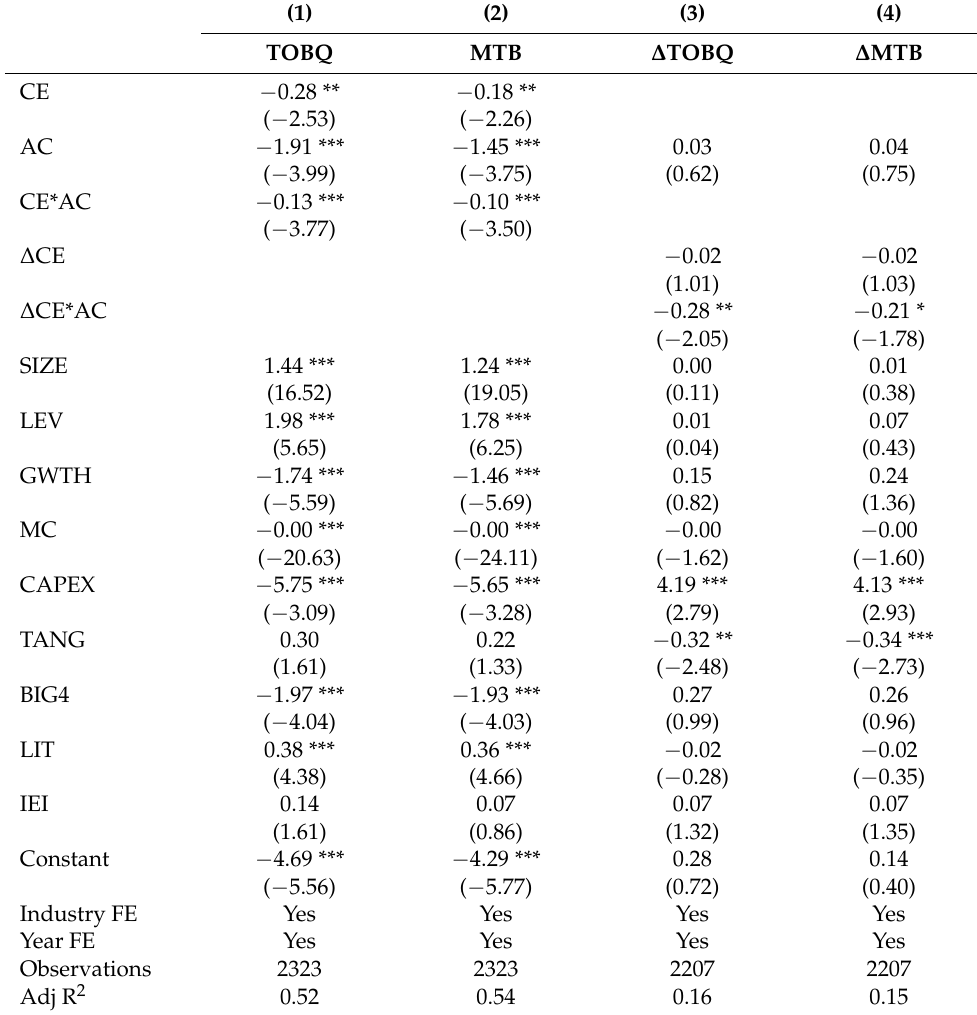
Table 4. The effect of carbon emissions and agency costs on firm